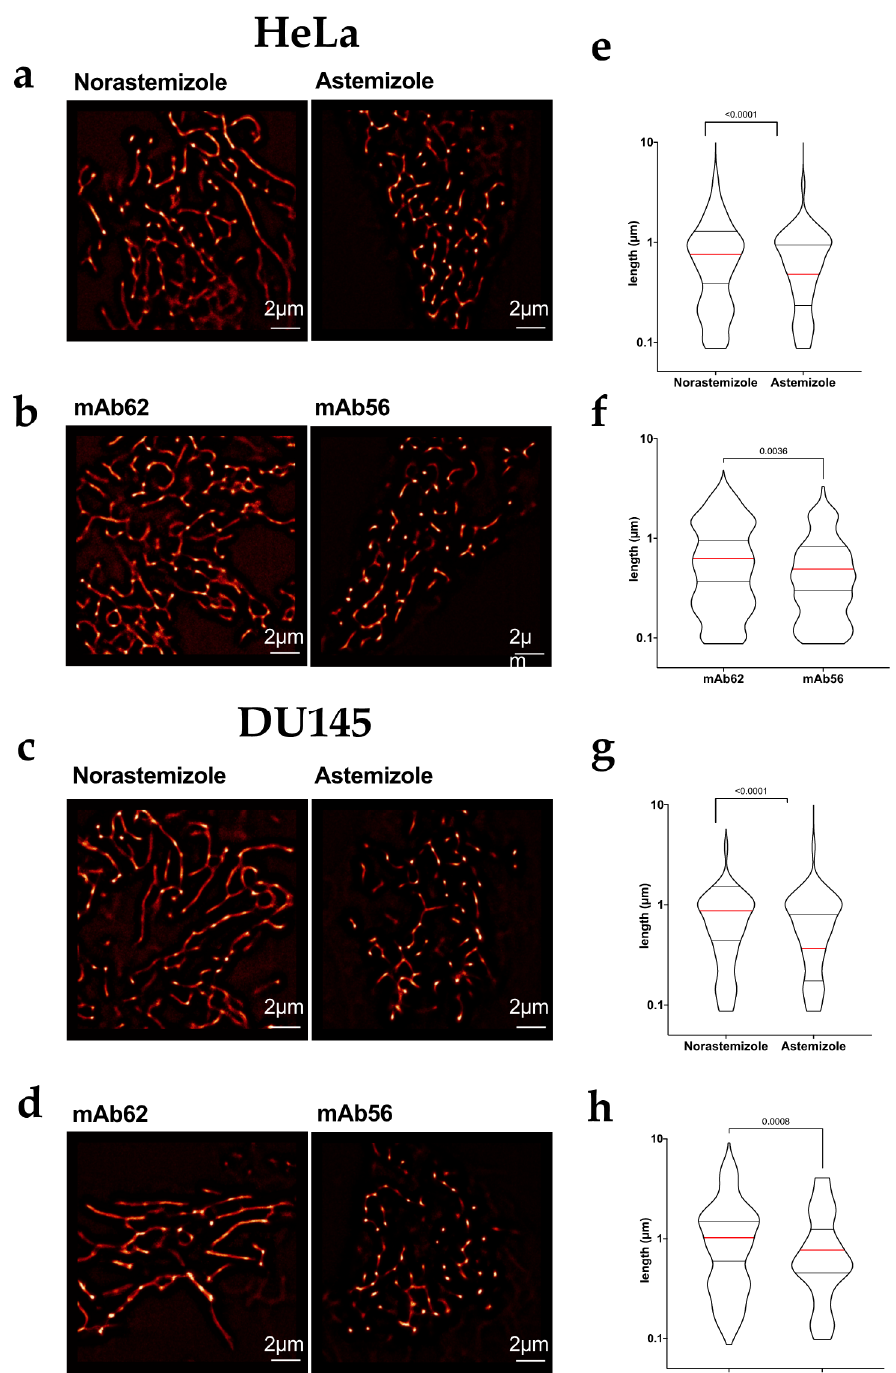
Figure 4. Pharmacological blockage of Kv10.1 induces mitochondrial fragmentation ( a – d ) Representative SRRF images of HeLa ( a , b ) and Du145 ( c , d ) cells treated with the indicated agents for 24 h, stained with Mitotracker Red and imaged in vivo using stacks of 200 images by spinning disc microscopy. Both blockers, Astemizole (5 µM) and mAb56 (10 µg/mL) induced mitochondrial fragmentation as compared with the respective controls Norastemizole and mAb62 at the same concentration. ( e – h ) The length of individual mitochondria under each condition was estimated by identifying skeletons in Fuji software. In e–h, the median value is indicated by a red line and the number indicates the value of p obtained by non-parametric Mann-Whitney test since the limit in resolution renders the distributions not normal.